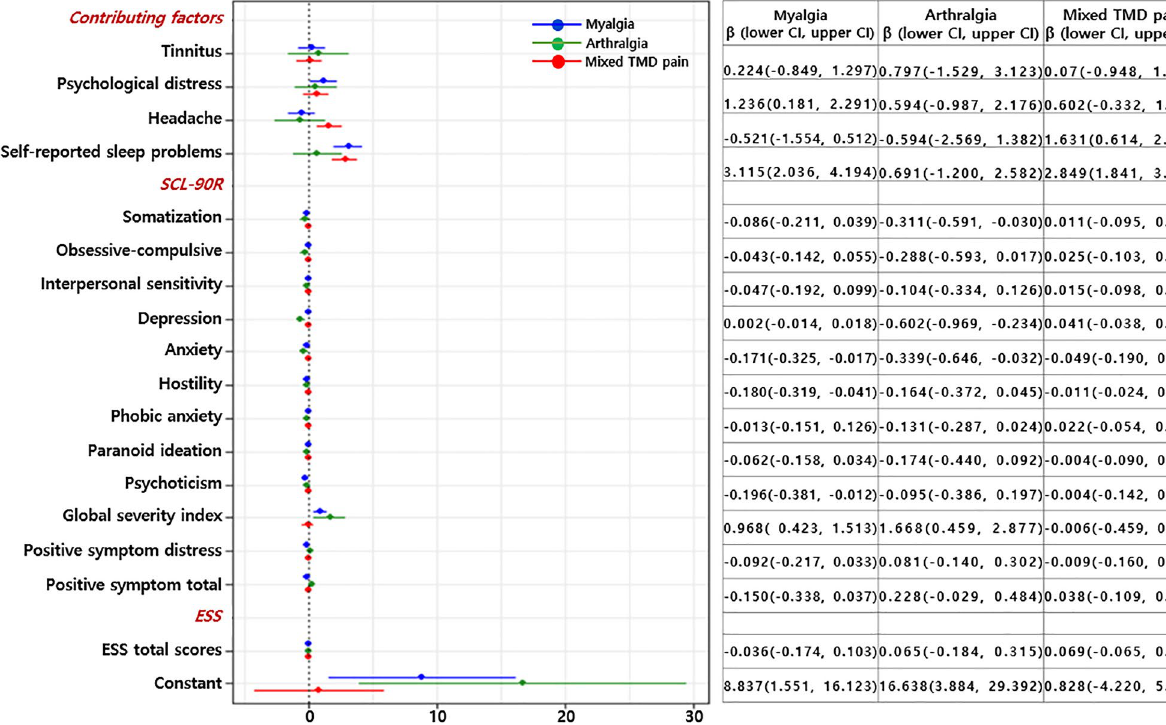
Figure 2. Linear regression analysis when assuming PSQI global scores as an independent variable. Myalgia group: R=0.689, R-squared=0.475, and adjusted R-squared=0.387; Arthralgia group: R=0.675, R-squared=0.455, and adjusted R-squared=0.245; Mixed TMD pain group: R=0.640, R-squared=0.410, and adjusted